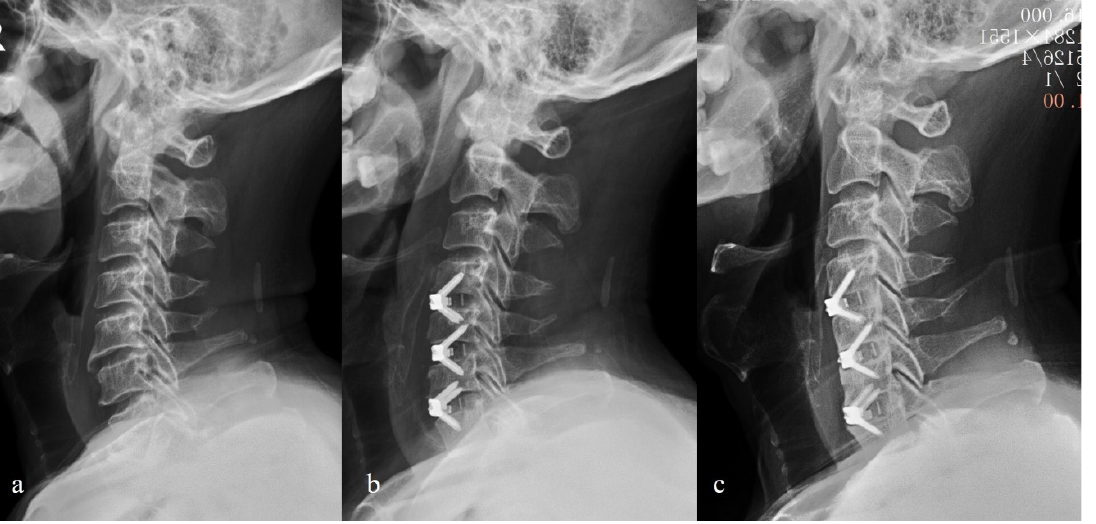
Figure 6. Lateral radiographs of one patient receiving Zero-P spacer system. ( a ) Preoperative C2-C7 Cobb angle was 15 degrees; ( b ) postoperative C2-C7 Cobb angle improved to 22 degrees; ( c ) the C2-C7 Cobb angle was 19 degrees at the 2-year follow-up.